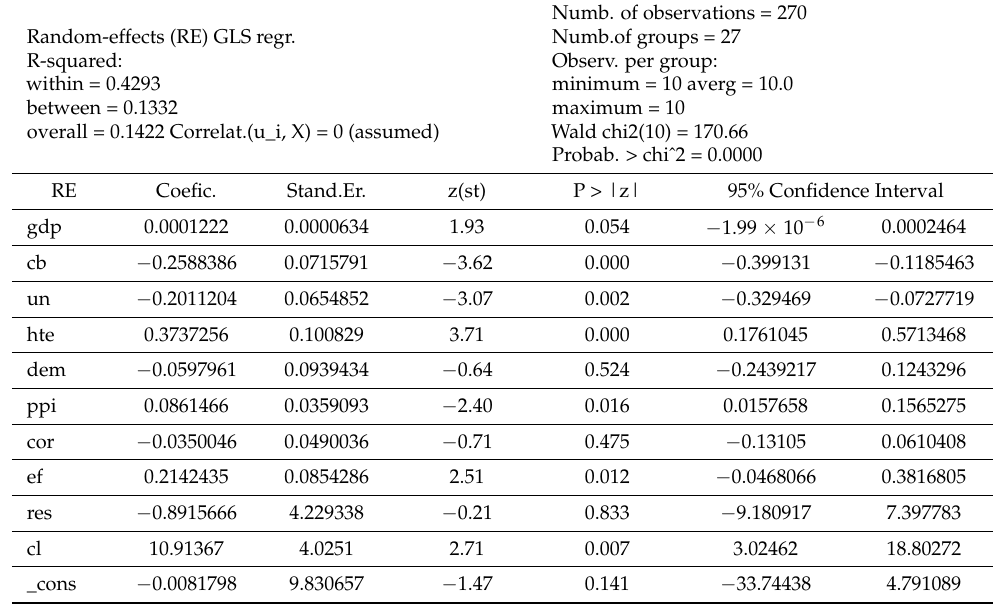
Table 1. The random-effects generalized least-squares (GLS) regression of the share of RE (%) for the panel of 27 EU members in 2011–2020. Random-effects (RE) GLS regr. R-squared: within = 0.4293 between = 0.1332 overall = 0.1422 Correlat.(u_i, X) = 0 (assumed)